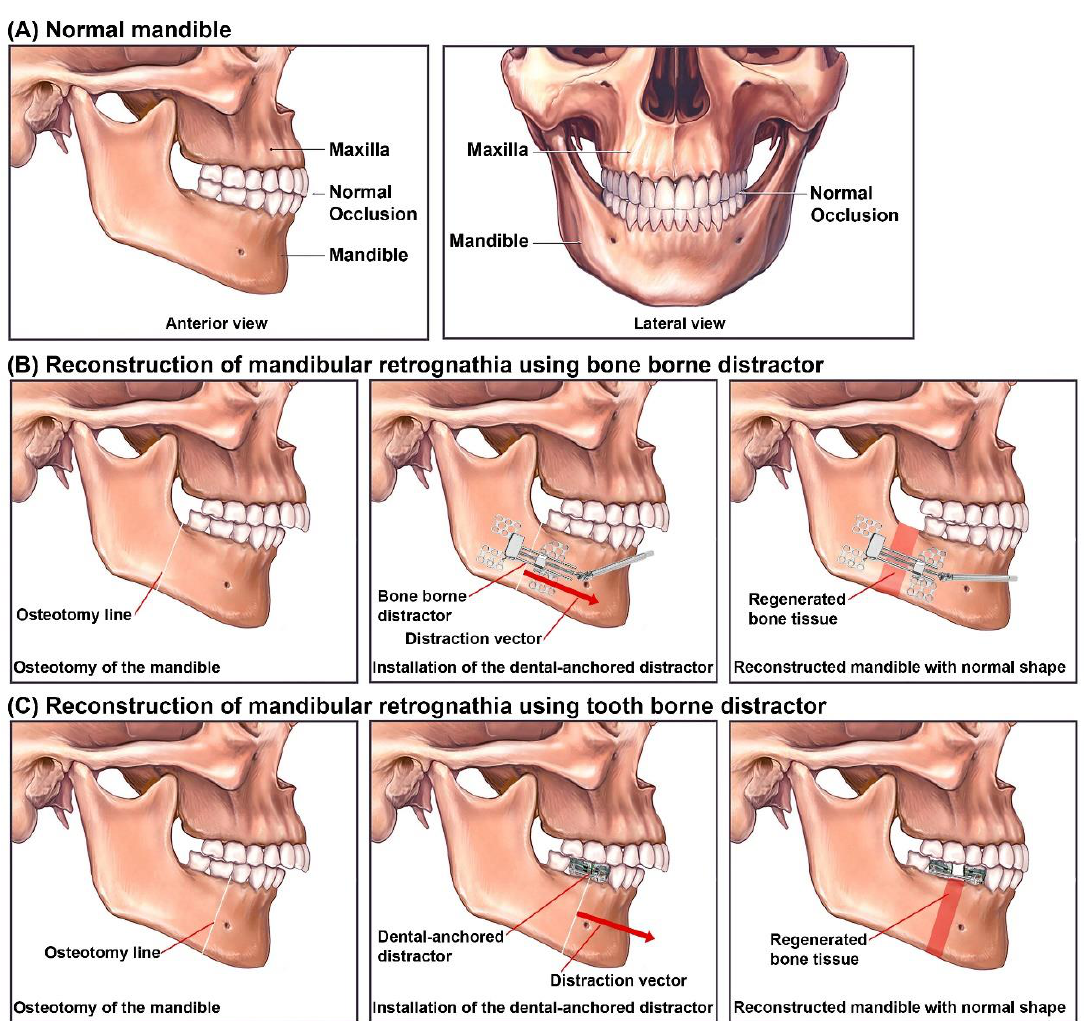
Figure 4. Reconstruction of mandibular retrognathia using BB and TB distractors: ( A ) Normal Mandible; ( B ) Reconstruction of mandible using BB distractor; ( C ) Reconstruction of Mandible using TB distractor